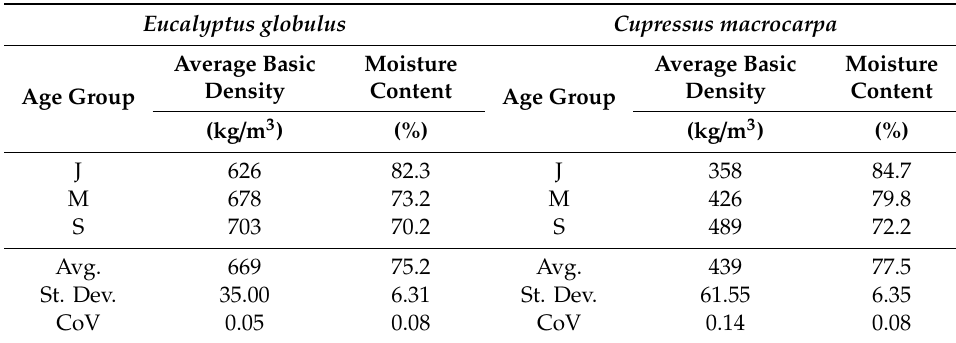
Table 4. Measured basic densities and moisture contents per wood age group of the Eucalyptus globulus and Cupressus macrocarpa